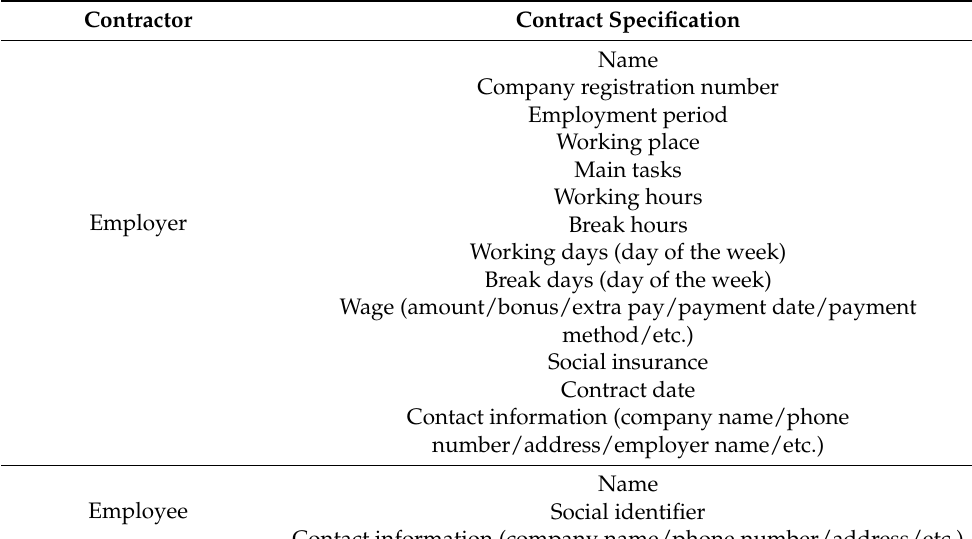
Table 1. Standard Employment Contract—Short